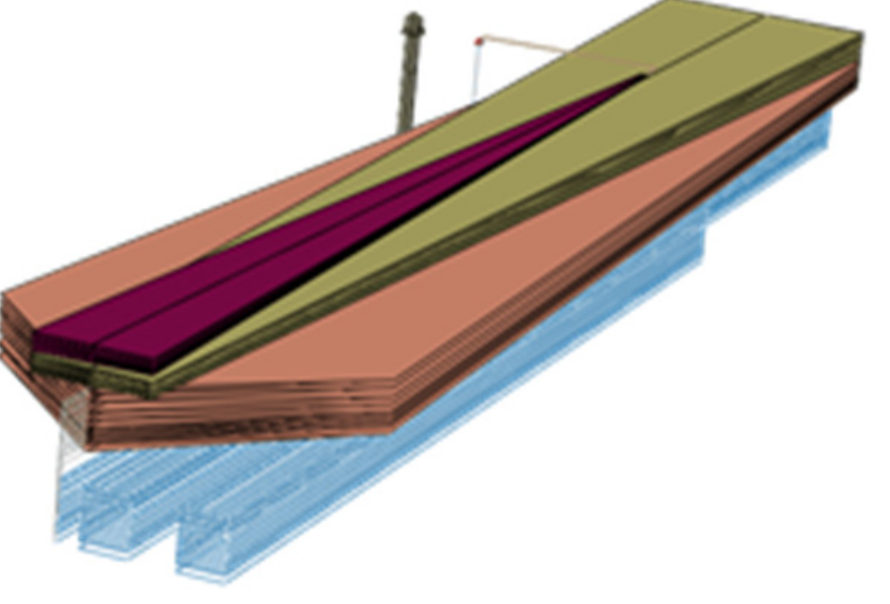
Figure 4. Simulation model. Table 2. Main parameters of